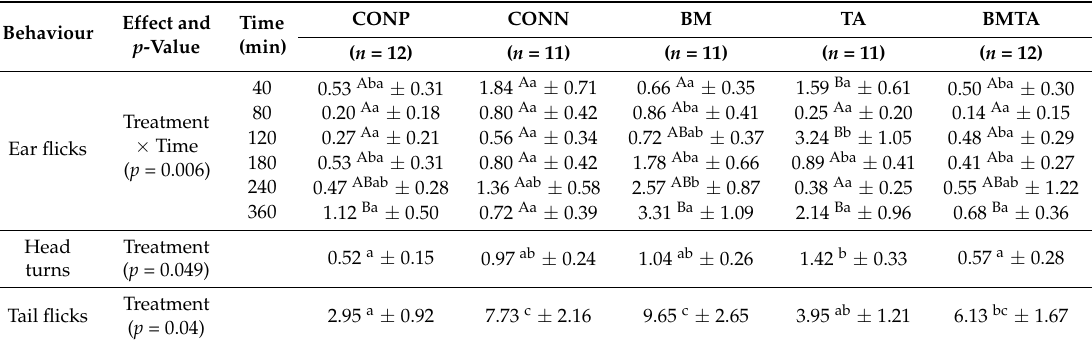
Table 4. Mean frequency of ear flicks, head turns and tail flicks displayed by calves in each treatment group within a 5-min focal sample at each